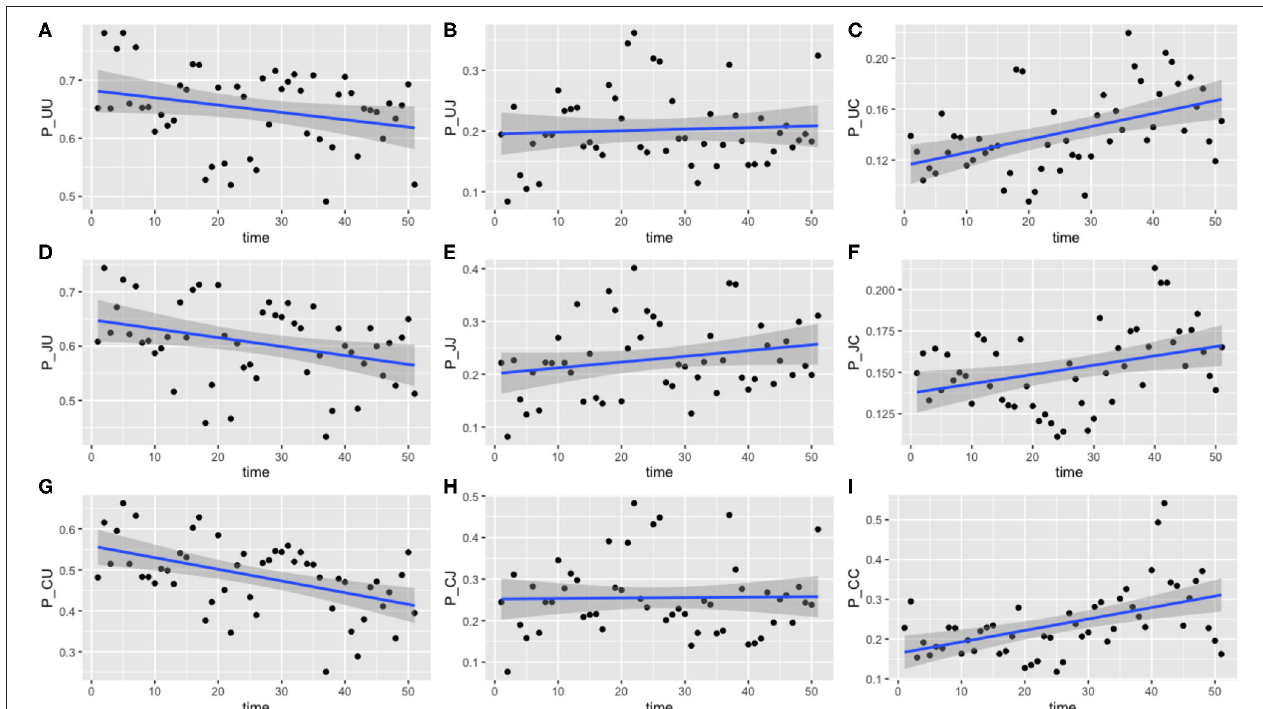
FIGURE 6 | Transition probabilities between three states, “uncolonized,” “colonized by C. jejuni ,” and “colonized by C. coli .” Plots show (A) π 1,1, t , (B) π 1,2, t , (C) π 1,3, t , (D) π 2,1, t , (E) π 2,2, t , (F) π 2,3, t , (G) π 3,1, t , (H) π 3,2, t , and (I) π 3,3, t against time. Each point is the calculated transition probability for that time point. Also plotted is a linear regression against these points in blue, with a shaded region depicting the 95% confidence interval of the regression. Five transition probabilities were found to